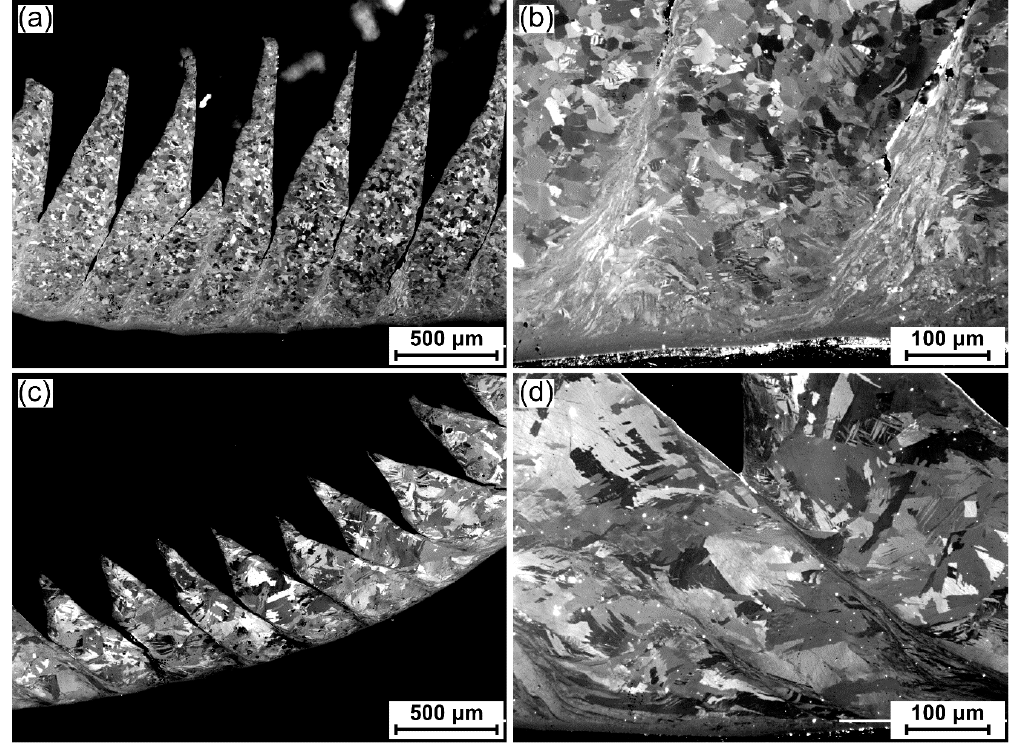
Figure 4. Cross-polarized light micrographs of the Ti-6Al-4V swarf feedstock. Two distinct microstructural varieties of swarf were identified: one in a mill-annealed condition with equiaxed α grains ( a ) low magnification; ( b ) high magnification; and one in a β annealed condition with transformed β grains containing an α colony structure ( c ) low magnification; ( d ) high magnification.